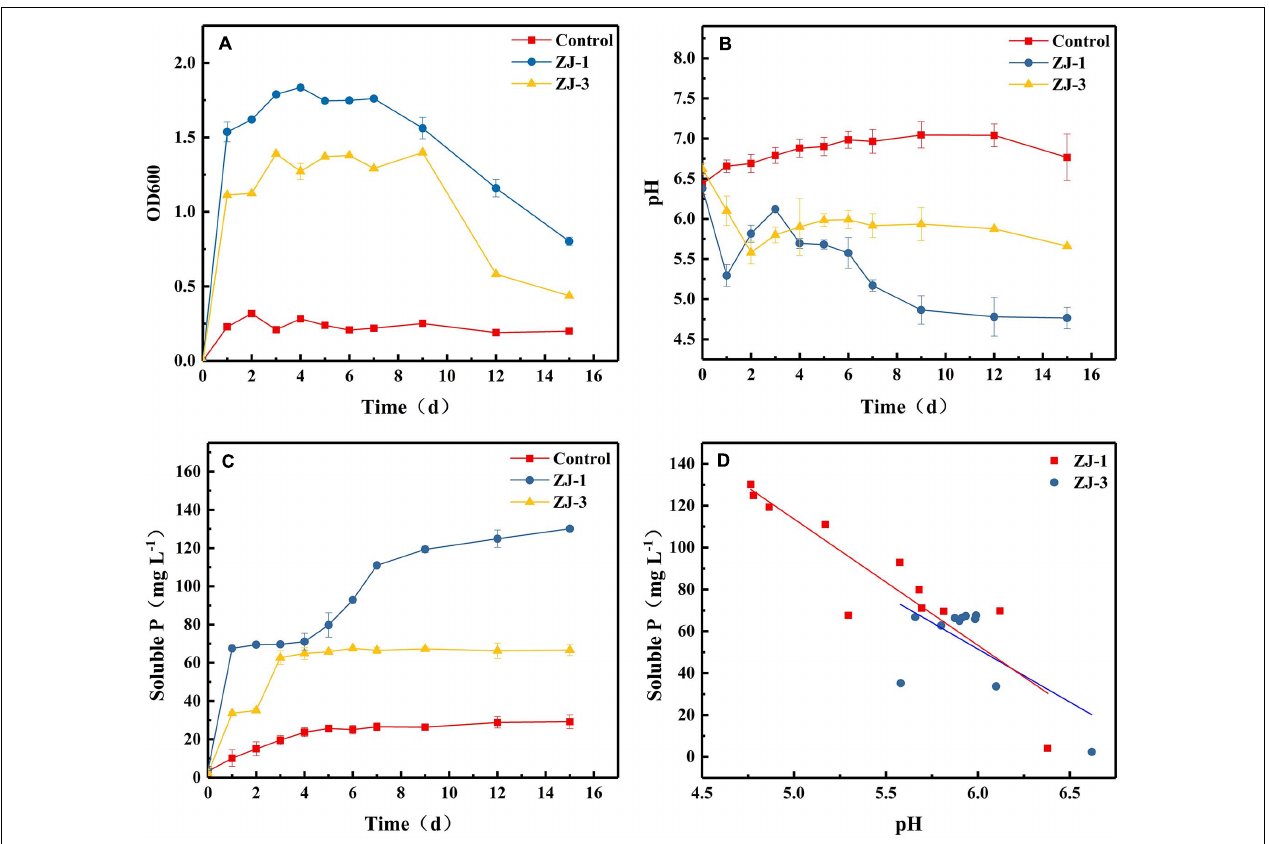
FIGURE 2 | The phosphate-solubilizing properties of PSB strains in NBRIP medium, demonstrated by orthophosphate release from Ca 3 (PO 4 ) 2 ; (A) OD600, (B) pH, (C) the solubilized P content, and (D) the relationship between pH and solubilized P